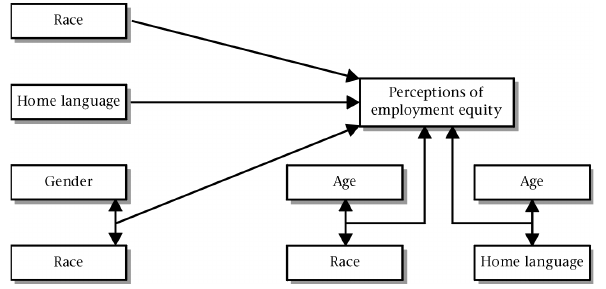
Figure 13: Biographical variables as predictors of the perceptions of black economic empowerment